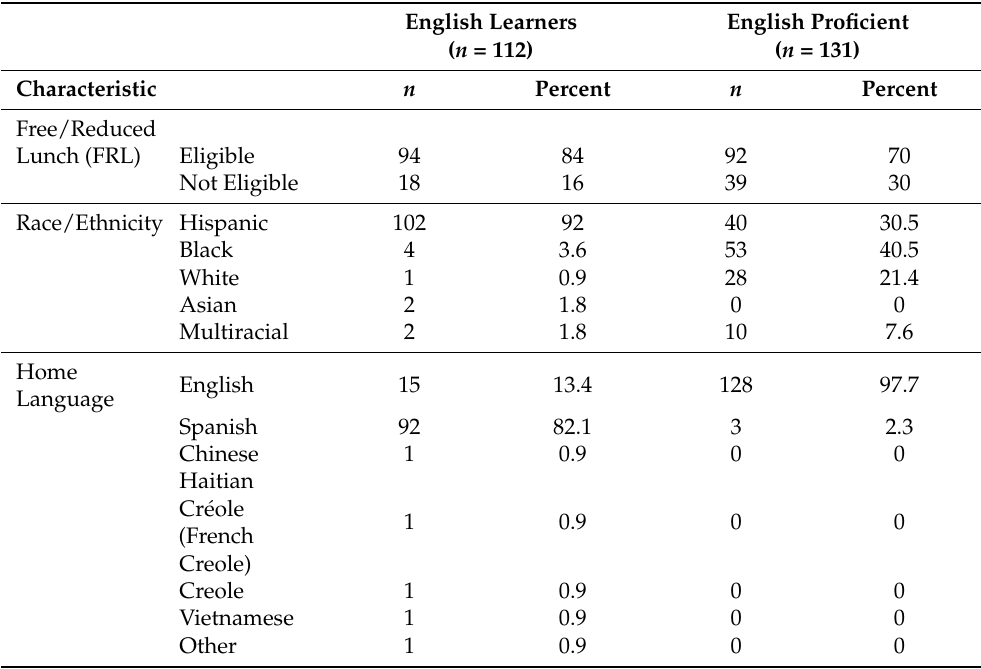
Table 1. Participant Demographics.